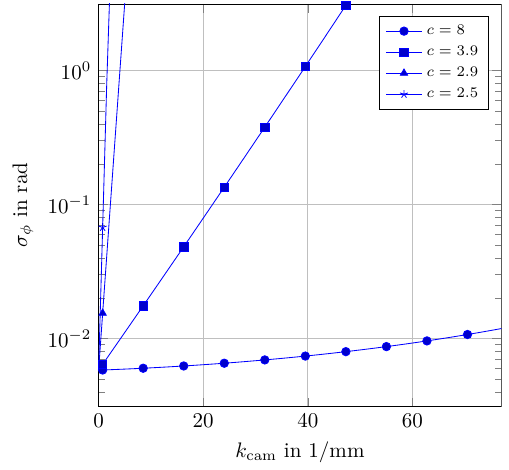
Figure 12. Deflectometric measurement uncertainty of the phase on the screen, showing a pattern with fringe frequency translating to k cam when reflected onto the